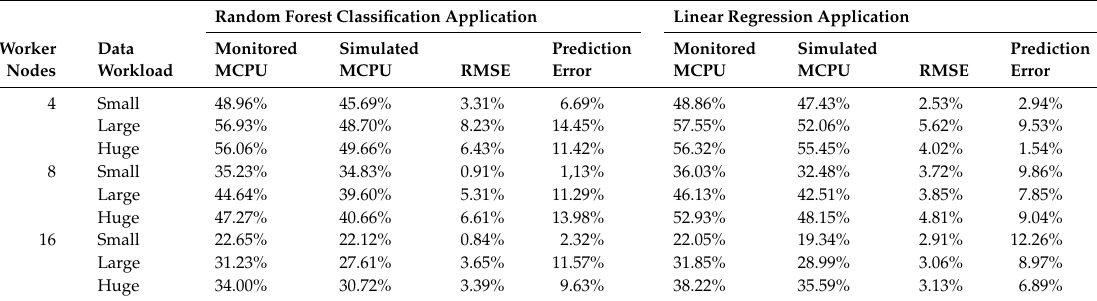
Table 5. Monitored and simulated mean CPU